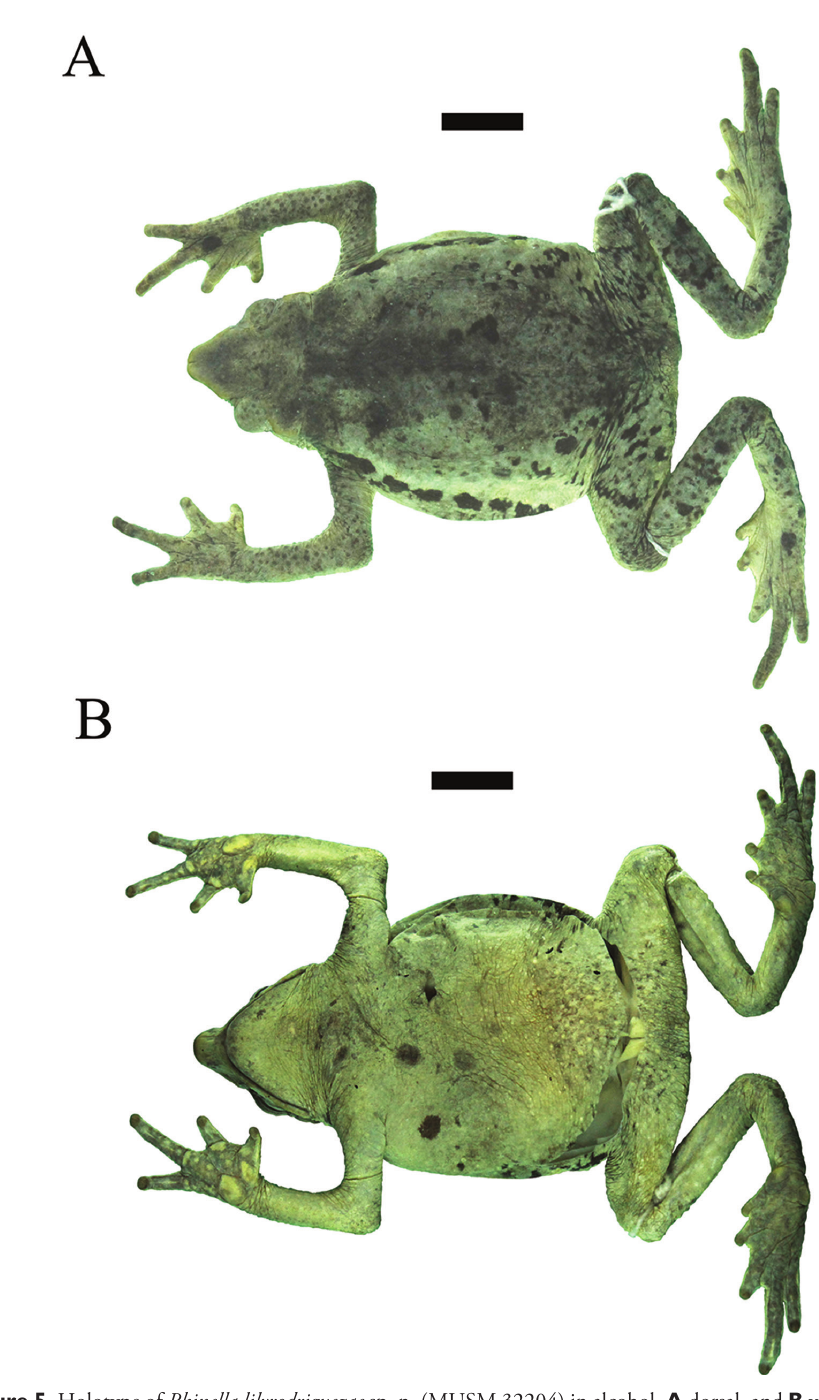
Figure 5. Holotype of Rhinella lilyrodriguezae sp. n. (MUSM 32204) in alcohol, A dorsal, and B ventral views. Scale bar 10 mm. Photos by J. C.